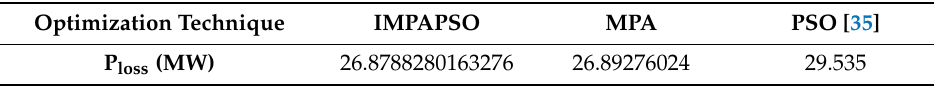
Table 5. IEEE 57-bus system’s first case objective